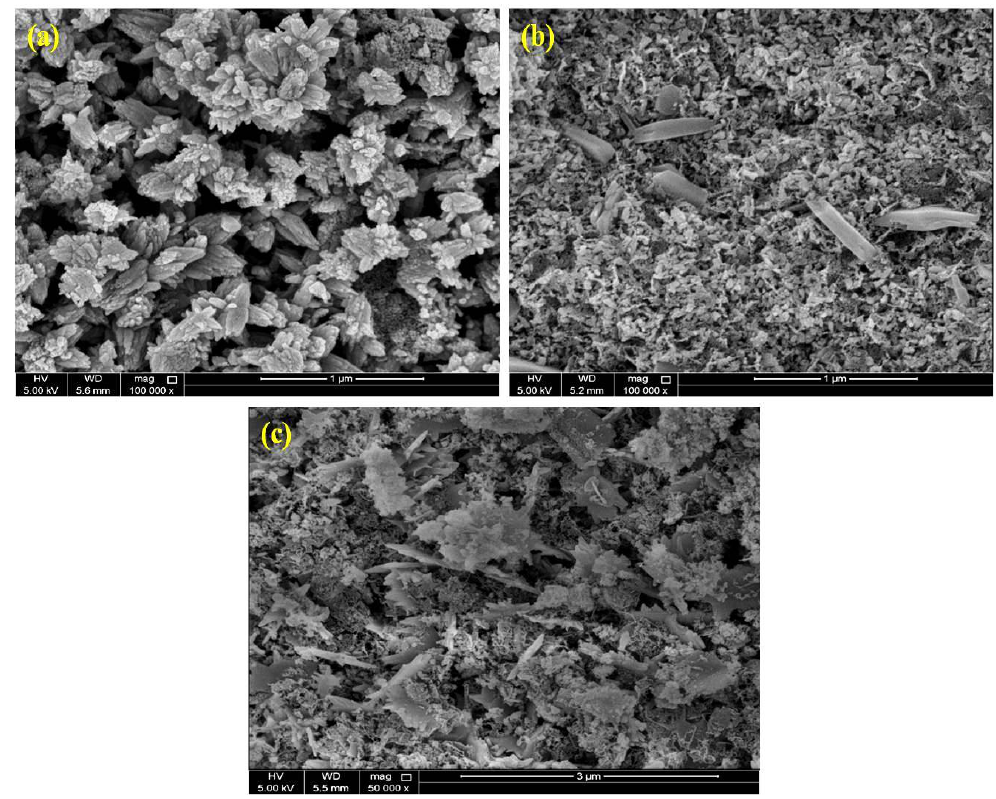
Figure 2. SEM images of the ( a ) ZnO-Fe, ( b ) ZnO-MXene, and ( c ) ZnO-Fe-MXene nanocomposites.